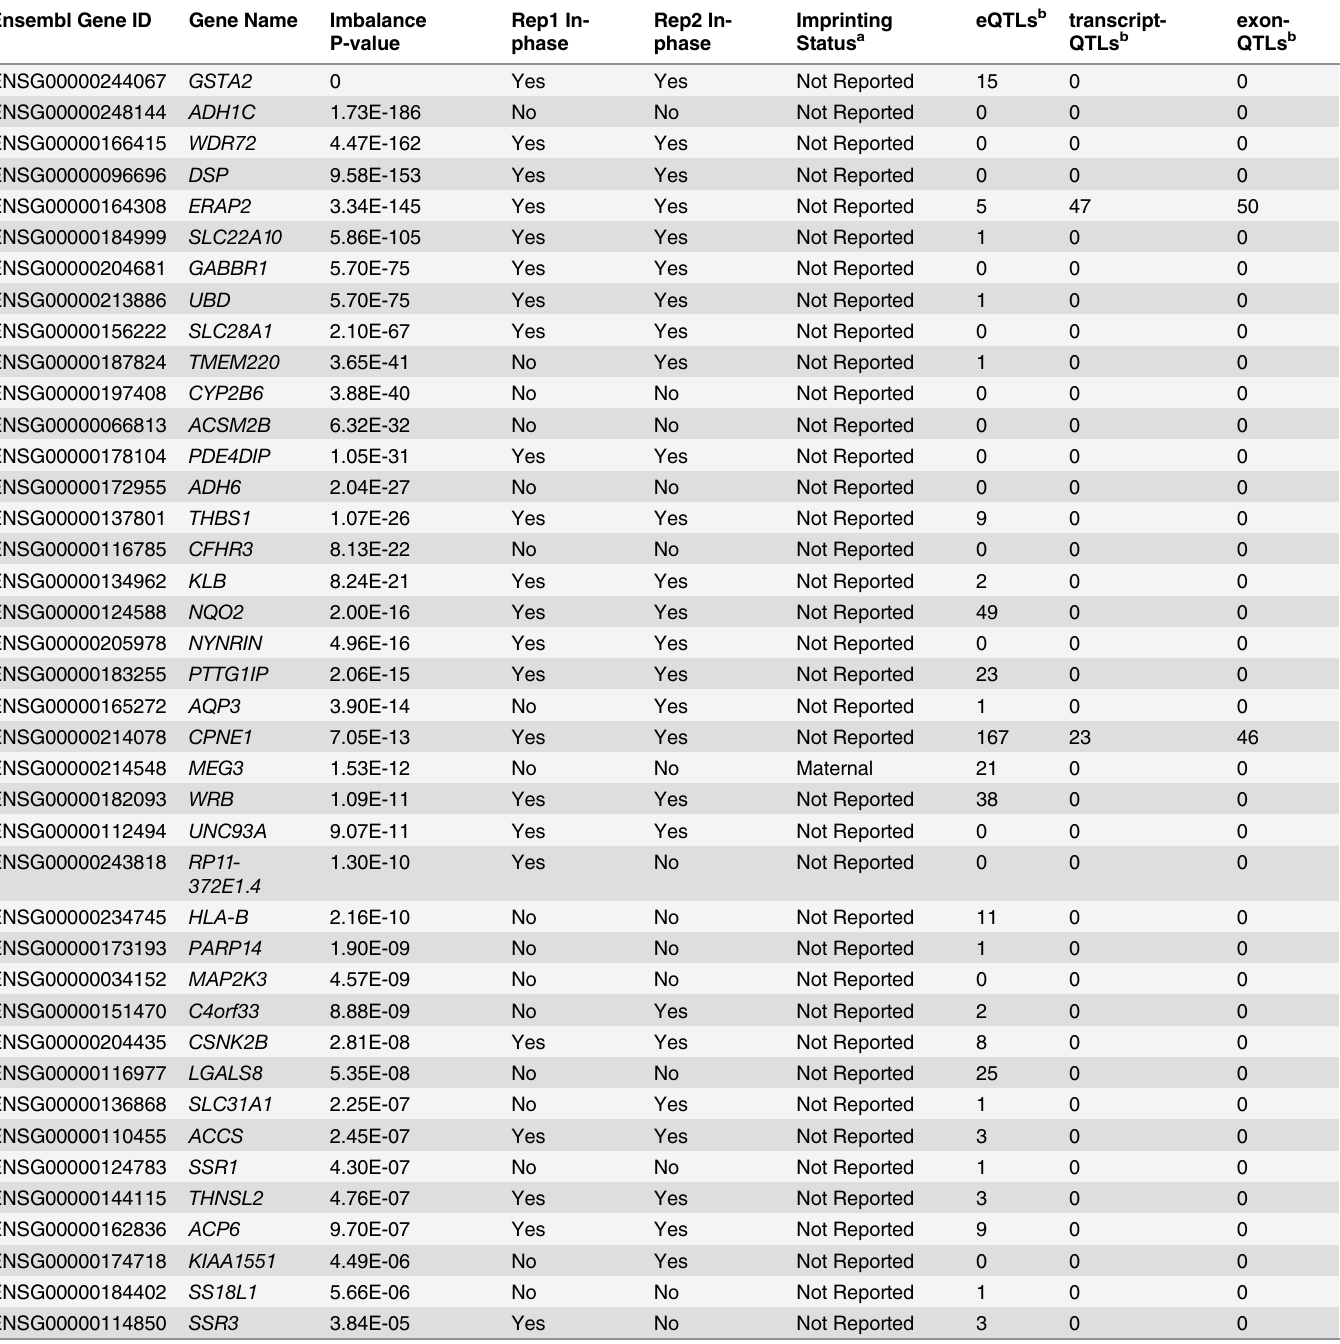
Table 2. Top ASE genes from the liver tissue sample. Ensembl Gene